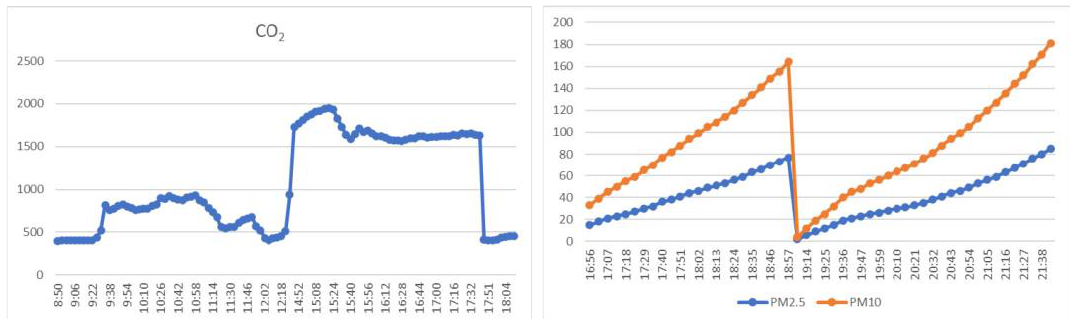
Figure 21. SmartAir kits.